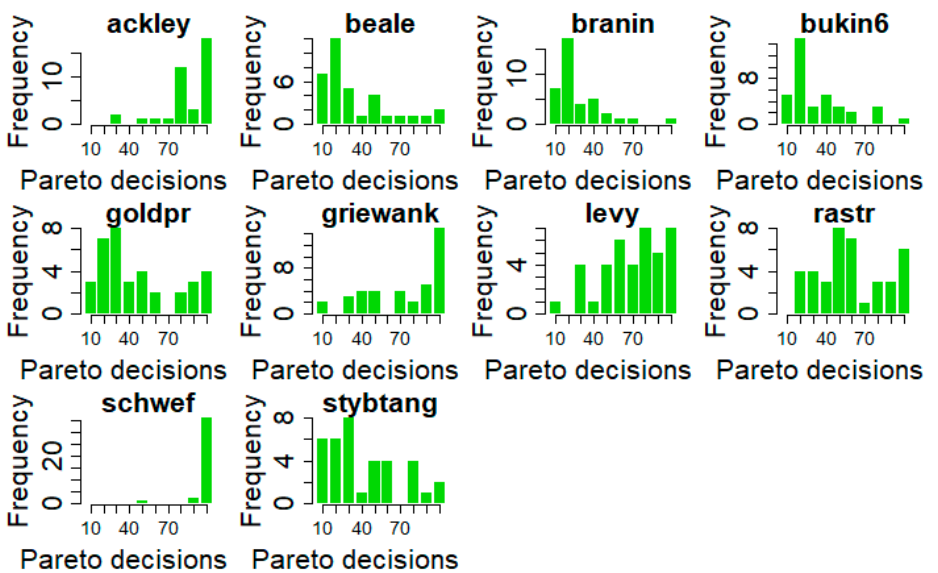
Figure 2. Number of human players ( y -axis) with respect to the percentage of Pareto decisions.